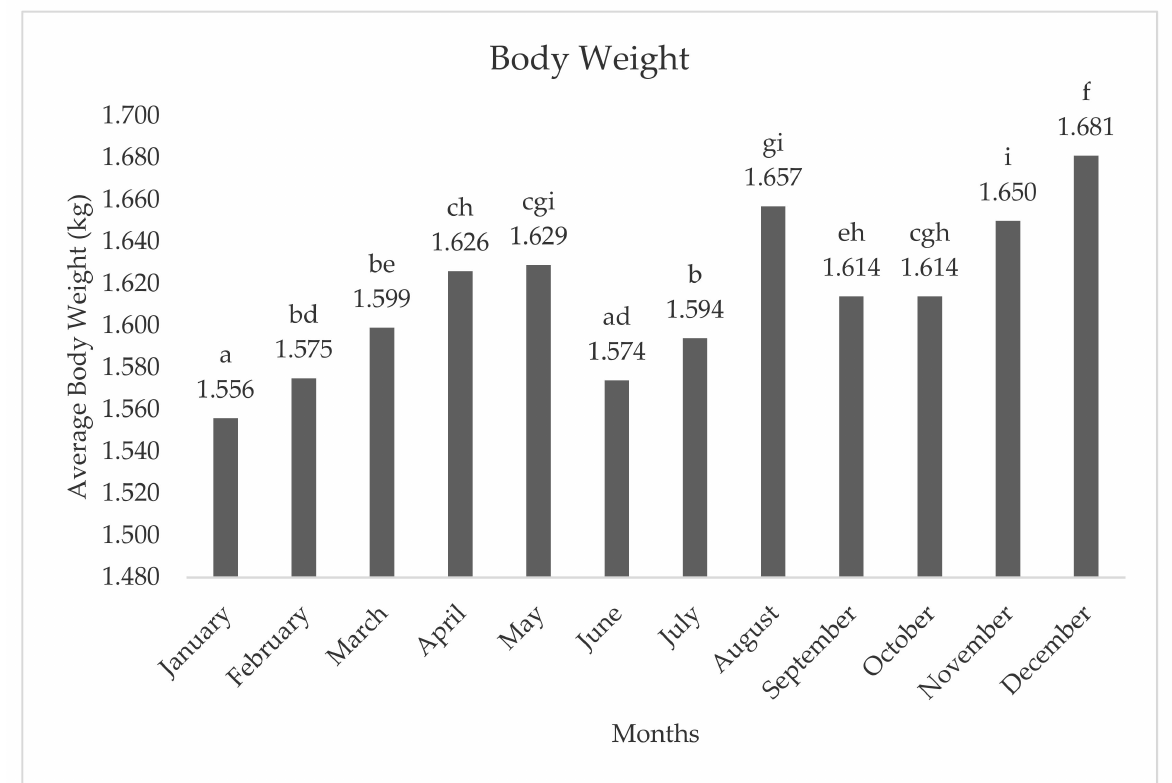
Figure 1. Average body weight at the end of lairage of hens by month. a – f ; different letters indicate statistical differences. Genotype, genotype x distance, and distance x genotype x season were found to be significant in predicting body weight loss ( p < 0.001) (Table 6). Distance and distance x season were significant, whereas genotype was not significant, within the model, in predicting the DOA rate. The model for predicting the reject rate was not significant for all variables ( p -value = 0.983). The reject rate could not be predicted by genotype, season, and distance. Table 6. Linear regression analysis between different variables. Model Adjusted Parameter Models